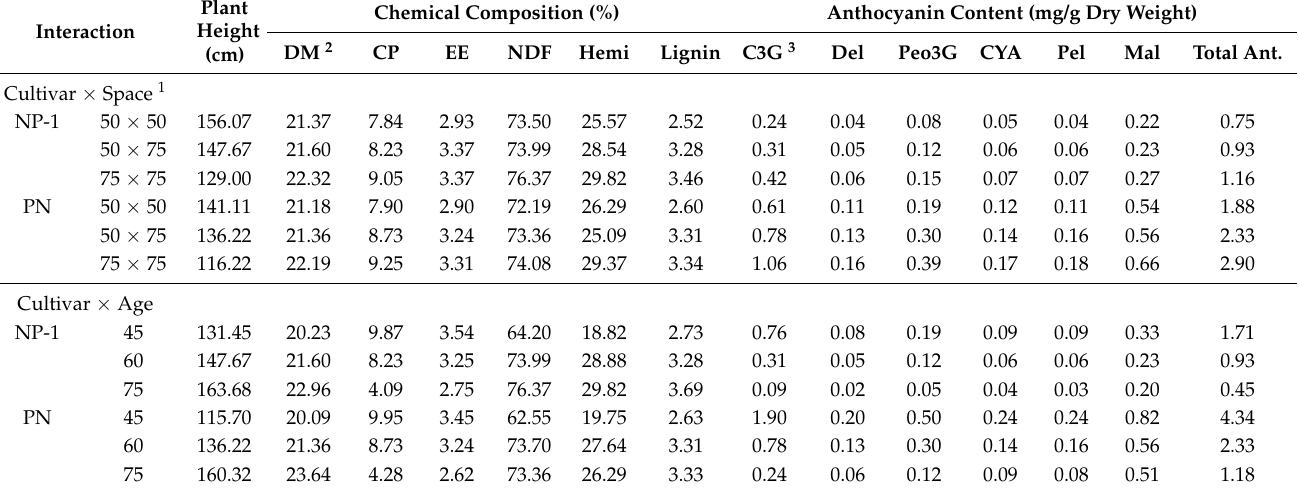
Table 2. The effect of the interaction of cultivar × plant spacing, cultivar × harvesting age, and plant spacing × harvesting age on plant height, chemical composition, and anthocyanin content of fresh Napier